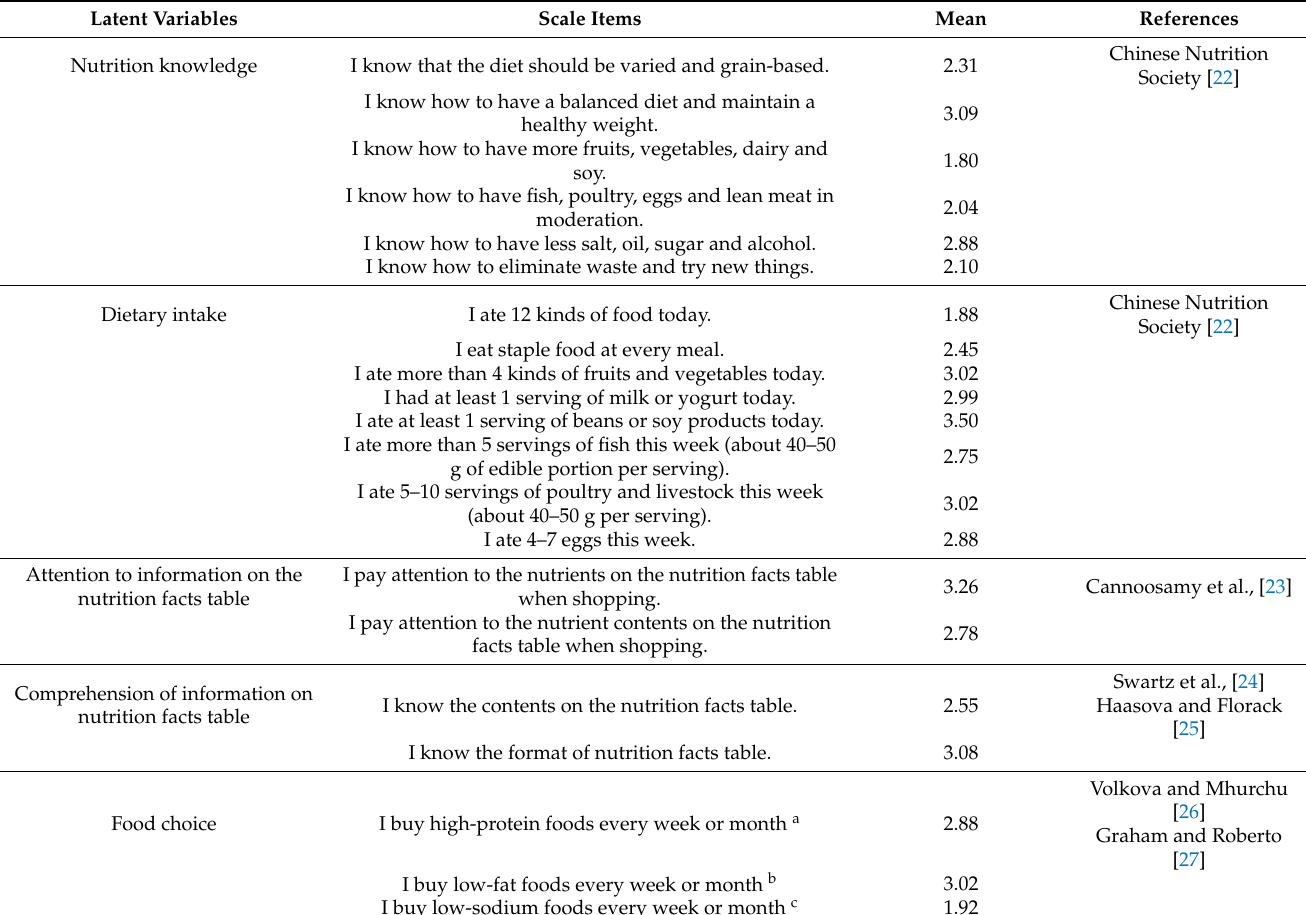
Table 2. Variables, scale items and